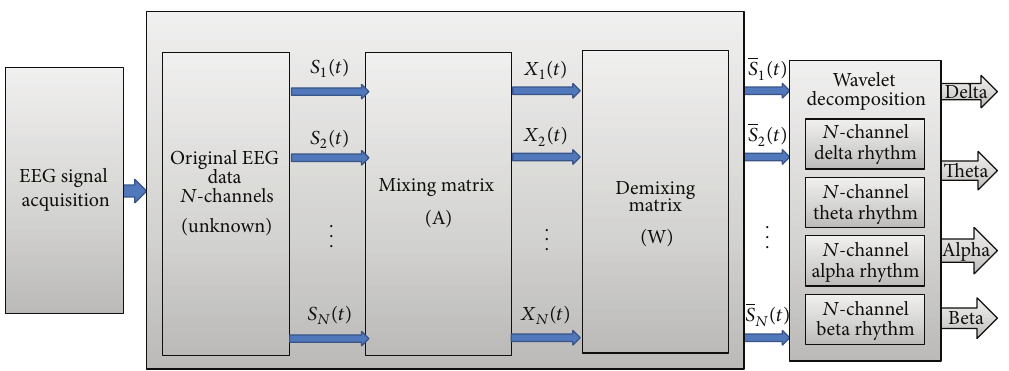
Figure 10: Block diagram of ICA-Wavelet for EEG